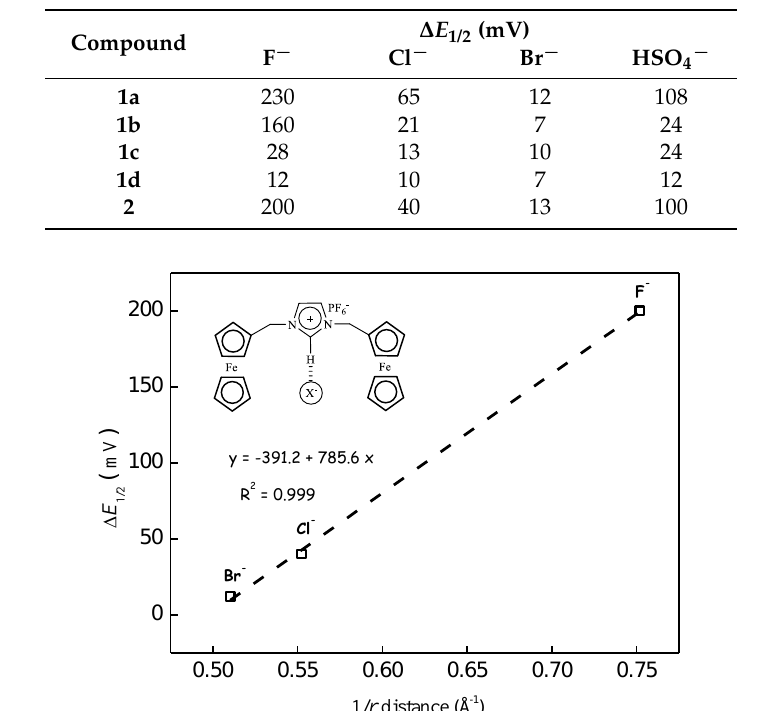
Table 2. Summary of the potential shifts measured in the presence of 10 molar equivalent of anions in acetonitrile solution.